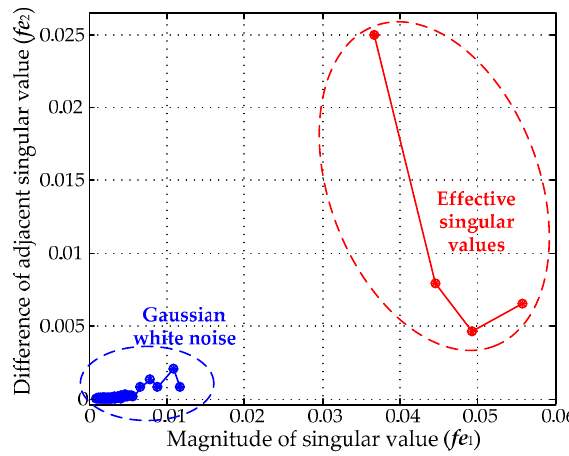
Figure 7. Selection results of effective singular values based on the FCM clustering algorithm.